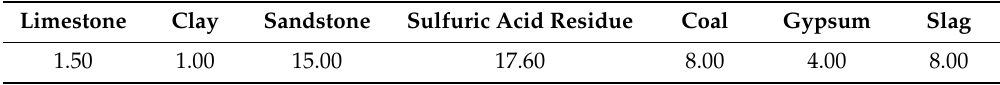
Table 5. The natural moisture of raw materials (%).